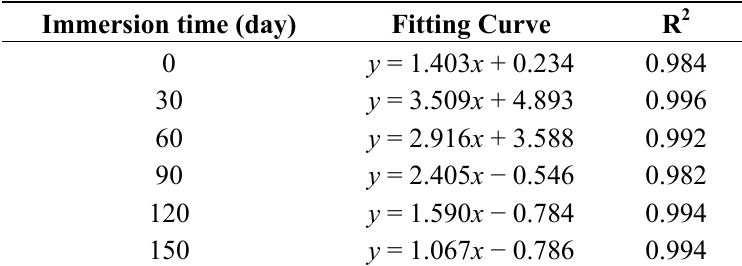
Table 3. The fitting of the permeability coefficient of CF15.